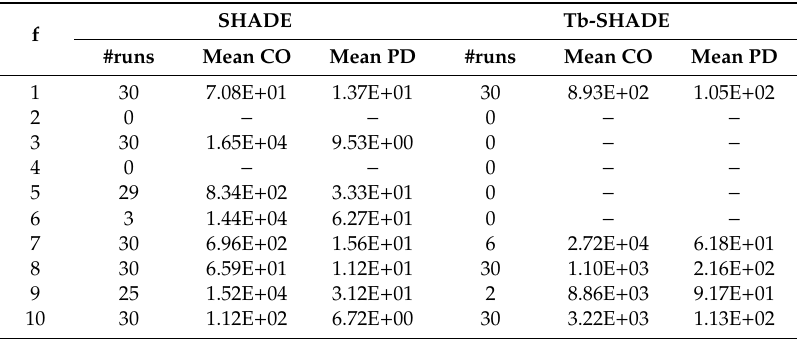
Table 25. Clustering and population diversity of SHADE and Tb-SHADE on the CEC2020 in 15 D .